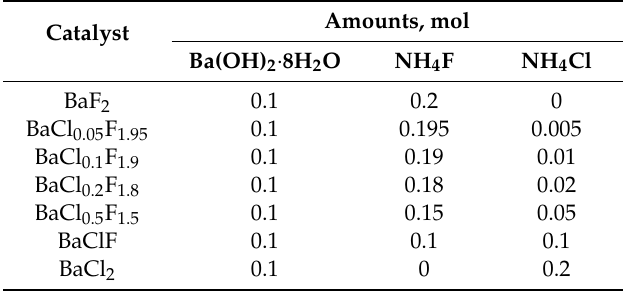
Table 1. Preparation conditions of catalysts for BaF 2 , barium chlorofluoride and BaCl 2 . Catalyst